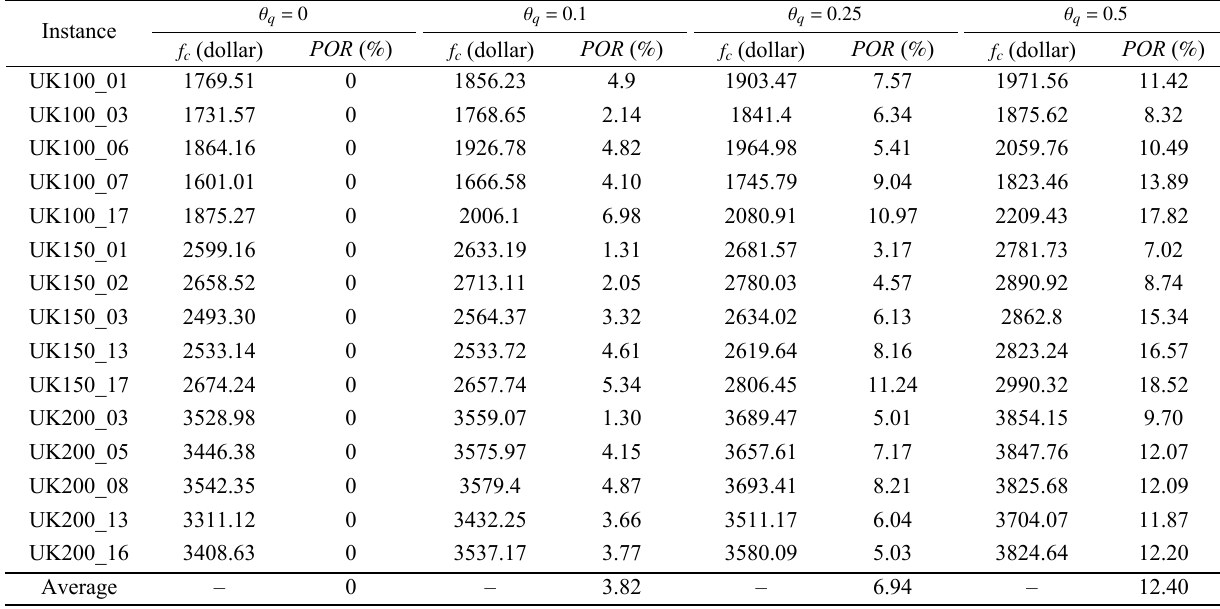
takes different q